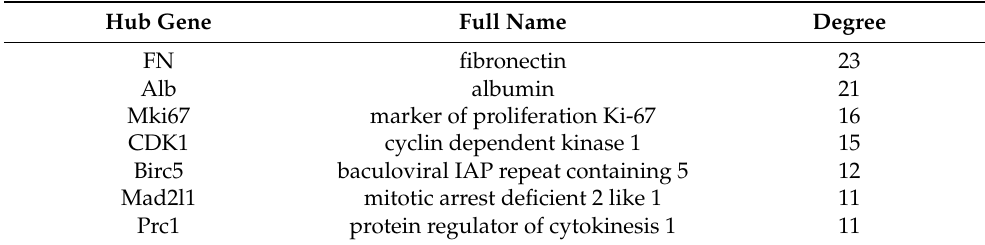
Table 3. Full names and degrees of hub genes. Hub